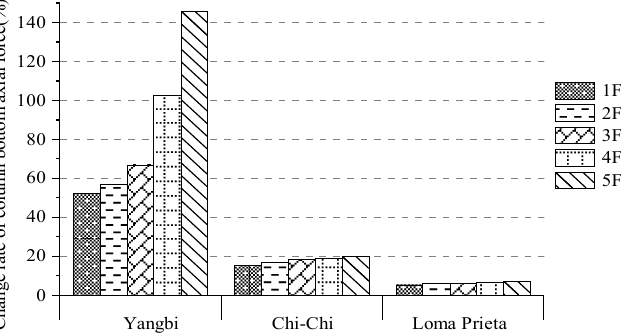
Figure 5. The change rate of the maximum axial force of columns bottom of each layer.